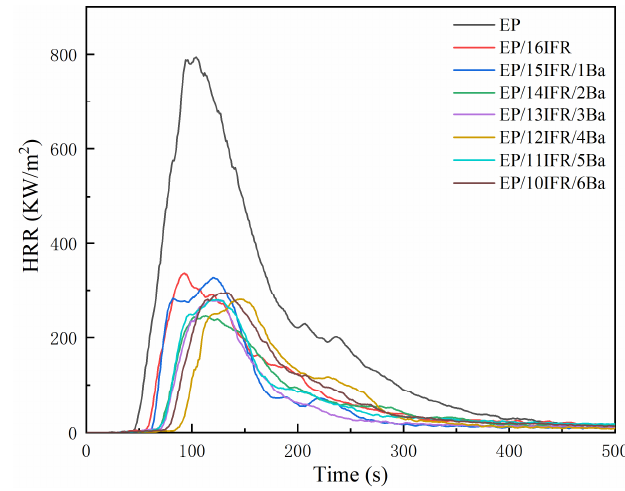
Figure 4. Curves of HRR of pure EP and EP composites with time.